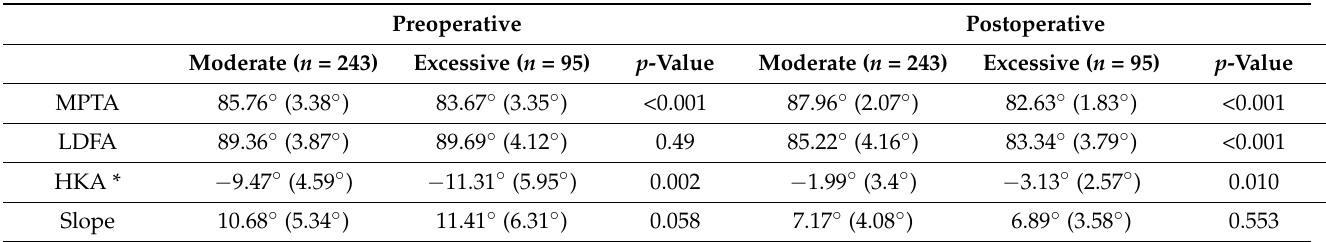
Table 2. Preoperative and postoperative alignment in the moderate and excessive groups.